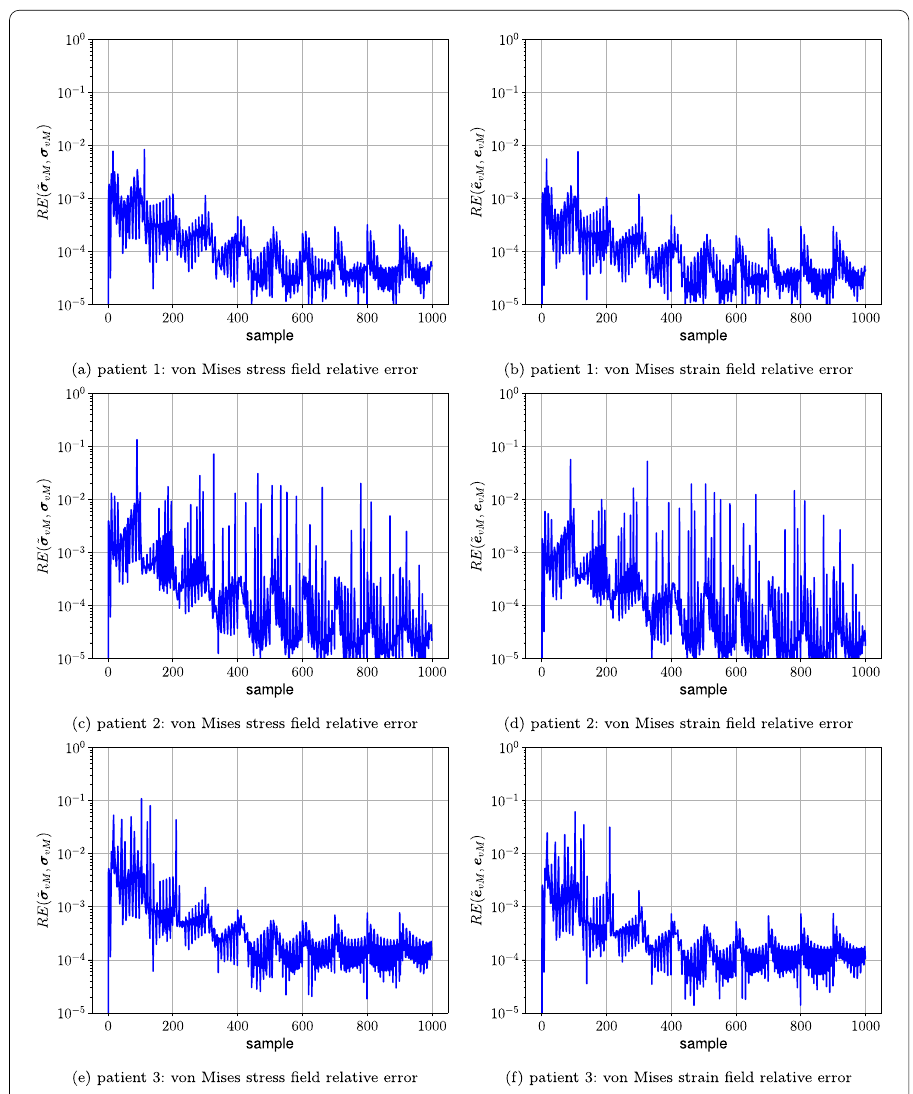
Fig. 11 Relative l2-error of the DROM in term of the von Mises stress and von Mises strain fields in the aortic wall. The test grid corresponds to a full factorial and equidistant 10 × 10 × 10 grid in the parameter domain. The results state individual simulations showing errors above 1%, while the majority ( > 98%) of simulations shows errors below